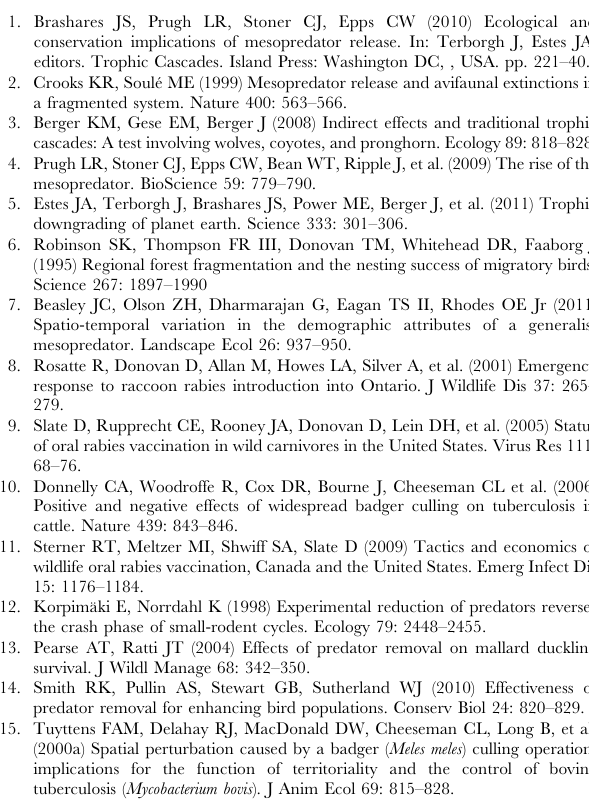
Table S1 Description of all habitat variables measured to examine the influence of habitat characteristics on raccoon population recovery in northcentral Indiana,